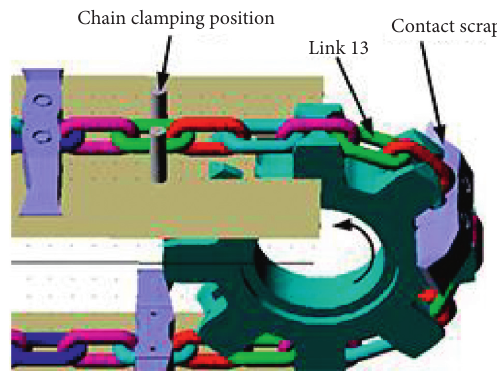
Figure 12: Chain stuck